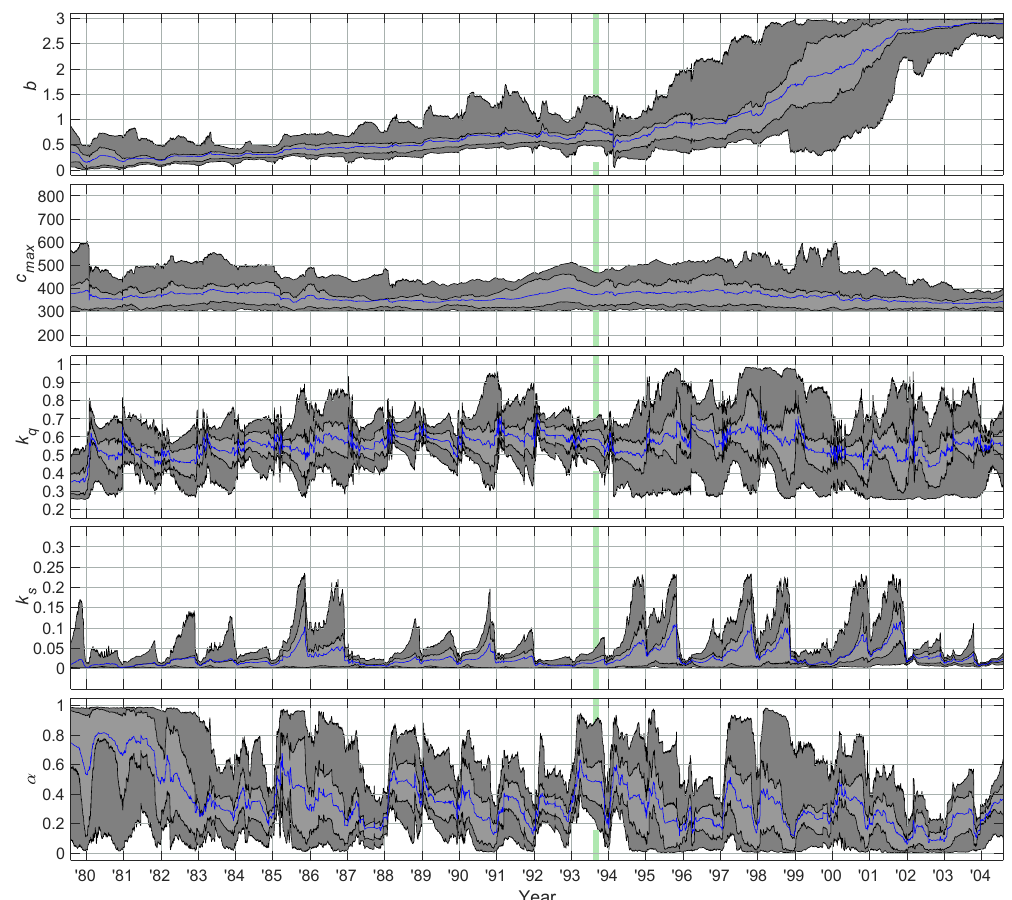
Figure 5. Parameter trajectories using the HyMOD model. The dark grey shaded areas indicate the middle 90% of the ensemble, bounded by the 5th and 95th percentiles. The light grey shaded areas indicate the middle 50% of the ensemble, bounded by the 25th and 75th percentiles. The ensemble mean is indicated by the blue line. The vertical green panel indicates the assumed time period of rapid